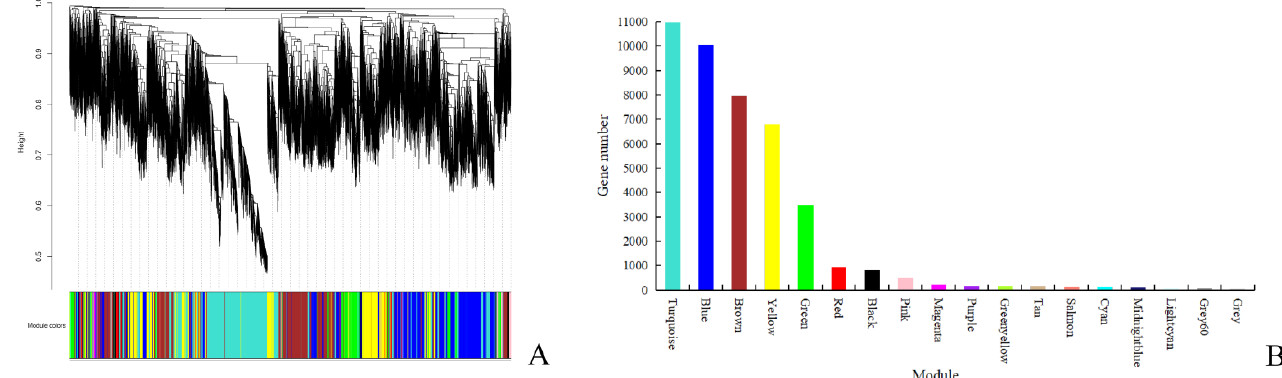
Figure 3. Clustering dendrograms of genes and module division. ( A ) Gene dendrogram by clustering the dissimilarity based on topological overlap. Each module was indicated by colors in the row, which contained a group of highly connected genes. ( B ) Distribution of gene number in modules. The x-axis represents different modules, and the y-axis represents gene numbers.